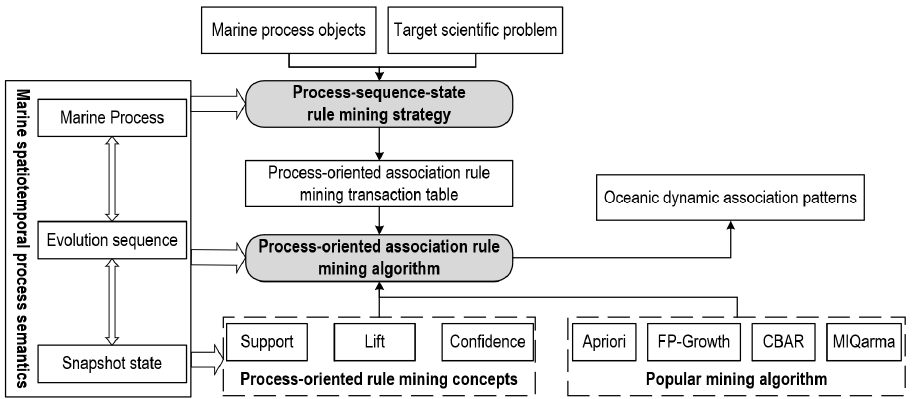
Figure 8. Workflow of process-oriented association rule mining module.